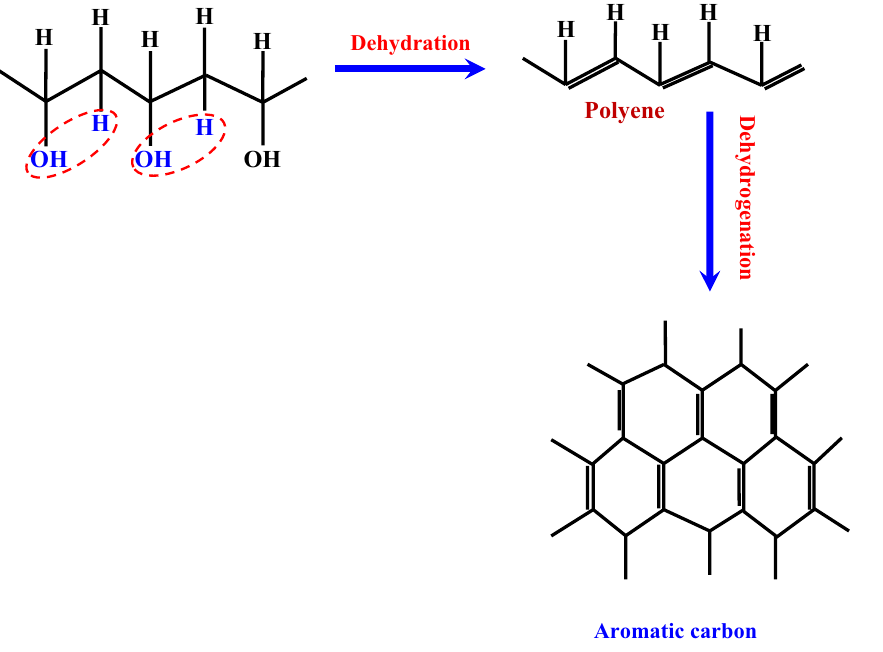
Figure 1. Schematic diagram for the expected optimum destructive of the PVA 41